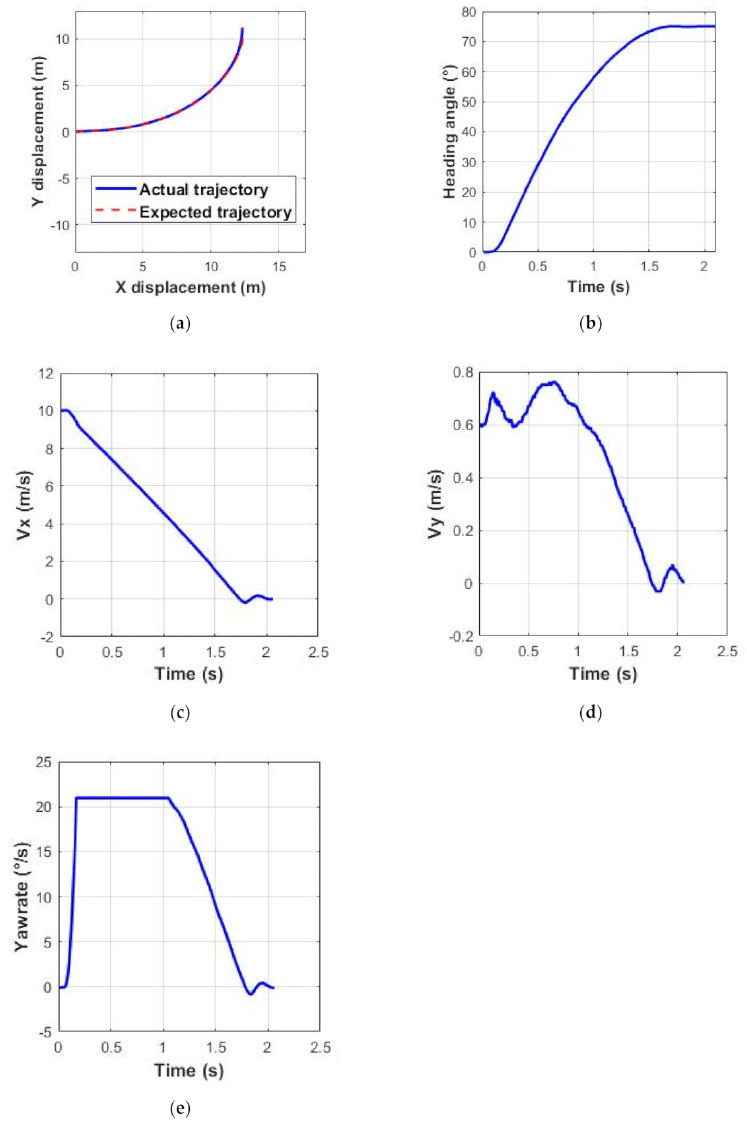
Figure 8. Ground test: ( a ) Vehicle path; ( b ) Heading angle; ( c ) Vx; ( d ) Vy; and ( e ) Yawrate. The drift trigger point is set to (0, 0), the distance threshold of the drift trigger point is set to 0.3 m, and the heading angle error threshold is set to 3 degrees. The vehicle meets the drift trigger condition and begins to drift. During the entire process of the vehicle drifting and entering the warehouse, the heading angle changes by 75.1 ◦ , the x- direction displacement changes by 12.32 m, and the y-direction displacement changes by 11.05 m. In contrast to the collected data, the heading angle deviation is 0.3 ◦ , the